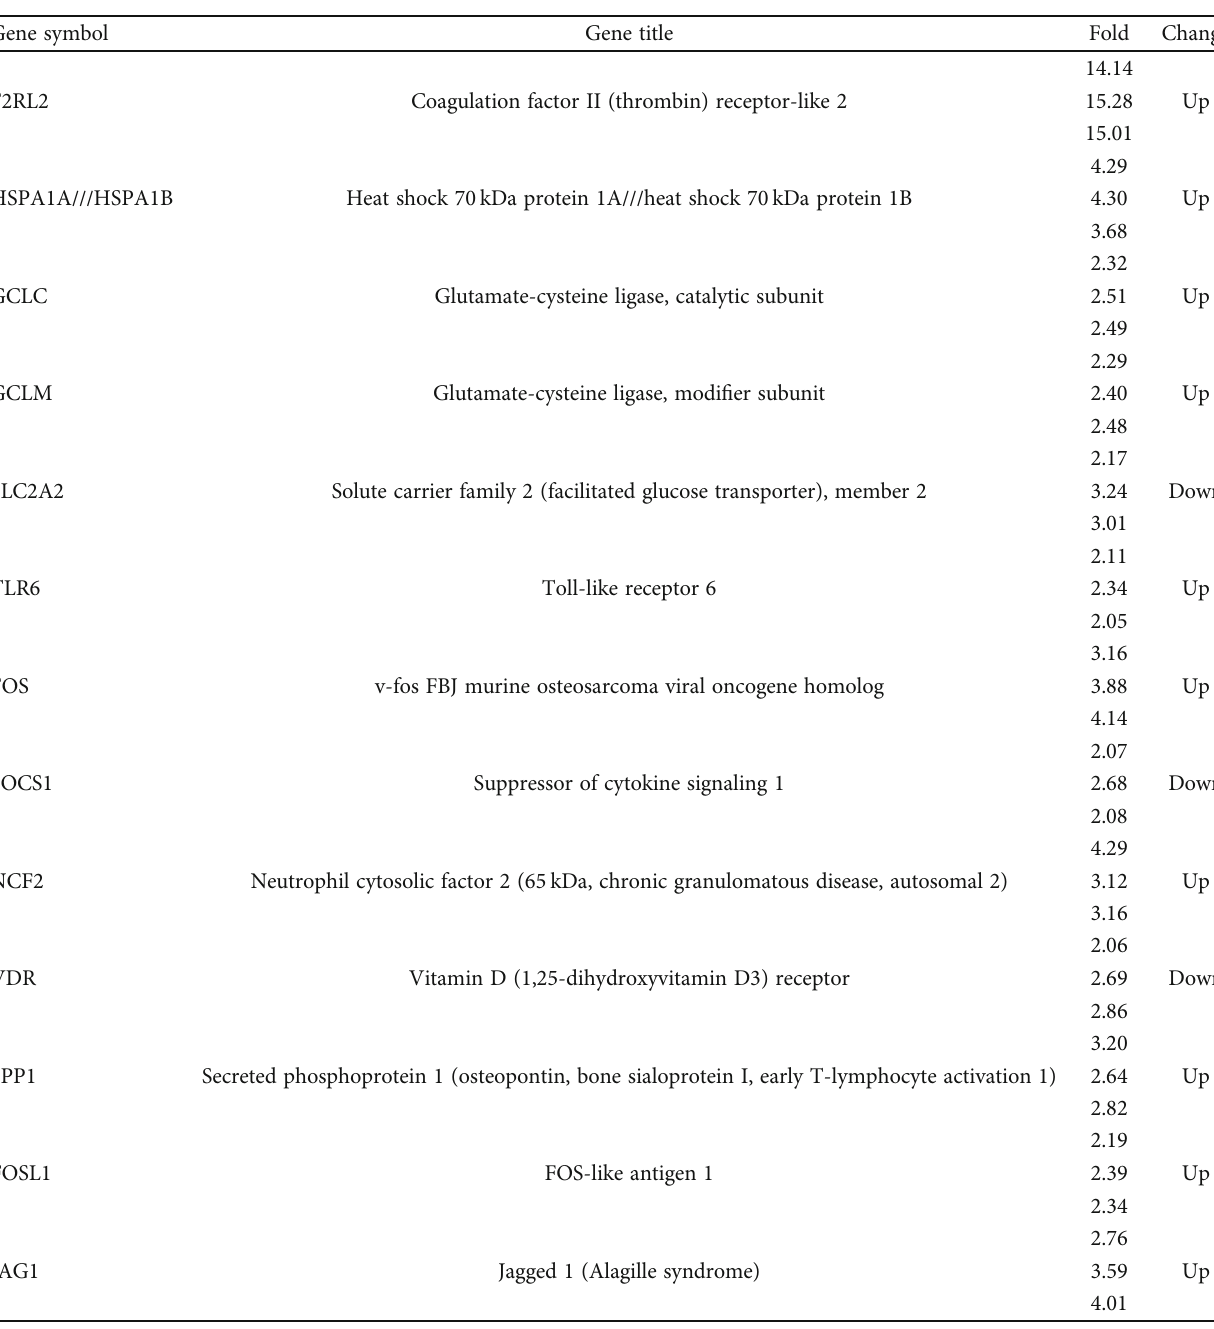
Table 5: DSs regulate the expression of genes related to cell proliferation and apoptosis. Gene